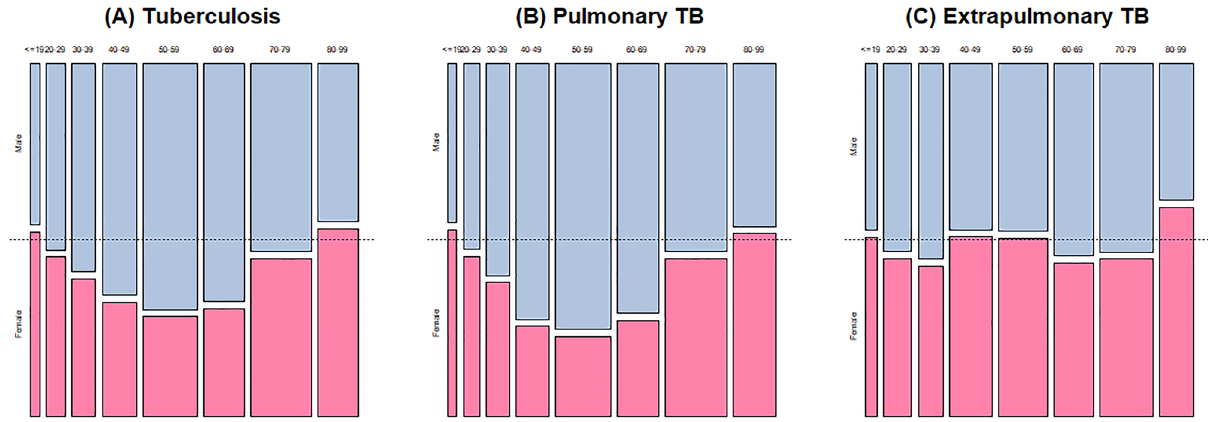
Figure 1. Changes of proportions of sex in 10-year age increments among ( A ) all the enrolled tuberculosis patients, ( B ) pulmonary tuberculosis patients, and ( C ) extrapulmonary tuberculosis patients. Areas of each box reflect relative number of patients in each group. TB